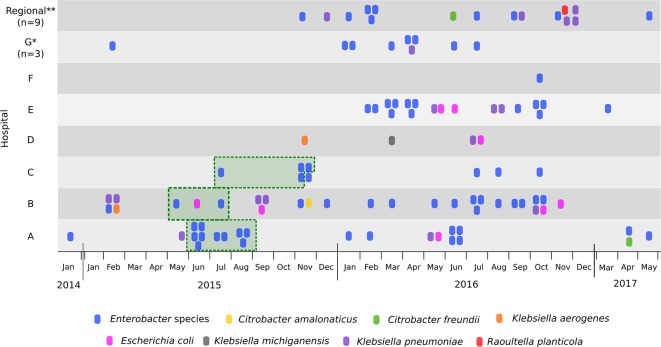
Timeline of samples from hospitals in Brisbane (Hospitals A–F) and Regional Queensland (QLD). Isolates in green boxes represent those related to the 2015 carbapenemase-producing 
E. hormaechei
 outbreak [34]. *Three hospitals located on the outskirts of Brisbane. **Nine hospitals from around Regional QLD. See Supplementary Data for a comprehensive list of isolates.